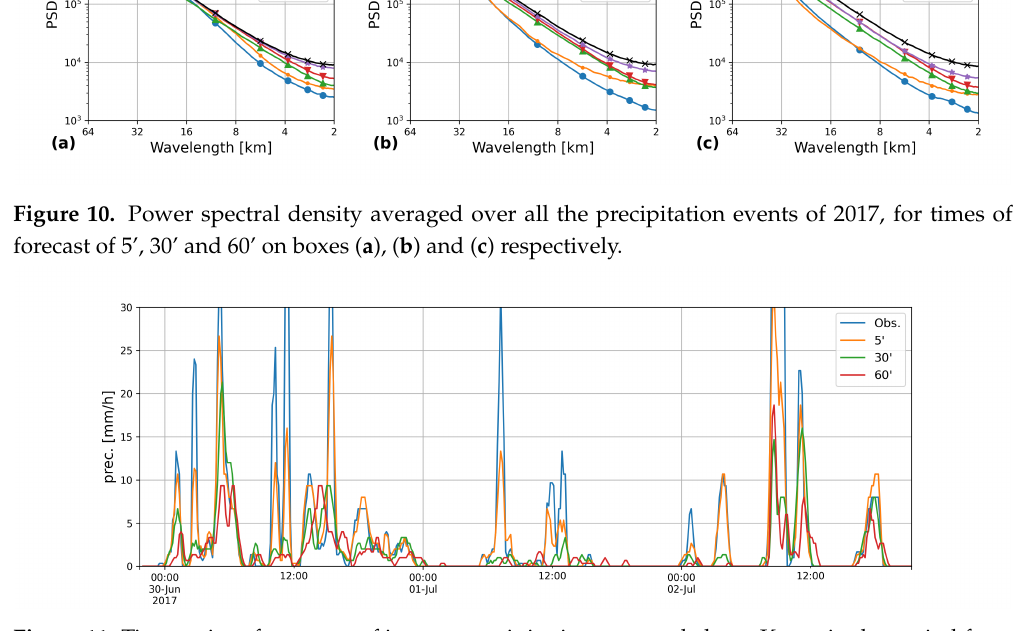
Figure 11. Time series of an event of intense precipitation occurred above Kyoto in the period from the 29 of June to the 2 of July 2017. Radar observations and corresponding NN forecasts at lead times of 5’, 30’ and 60’ are